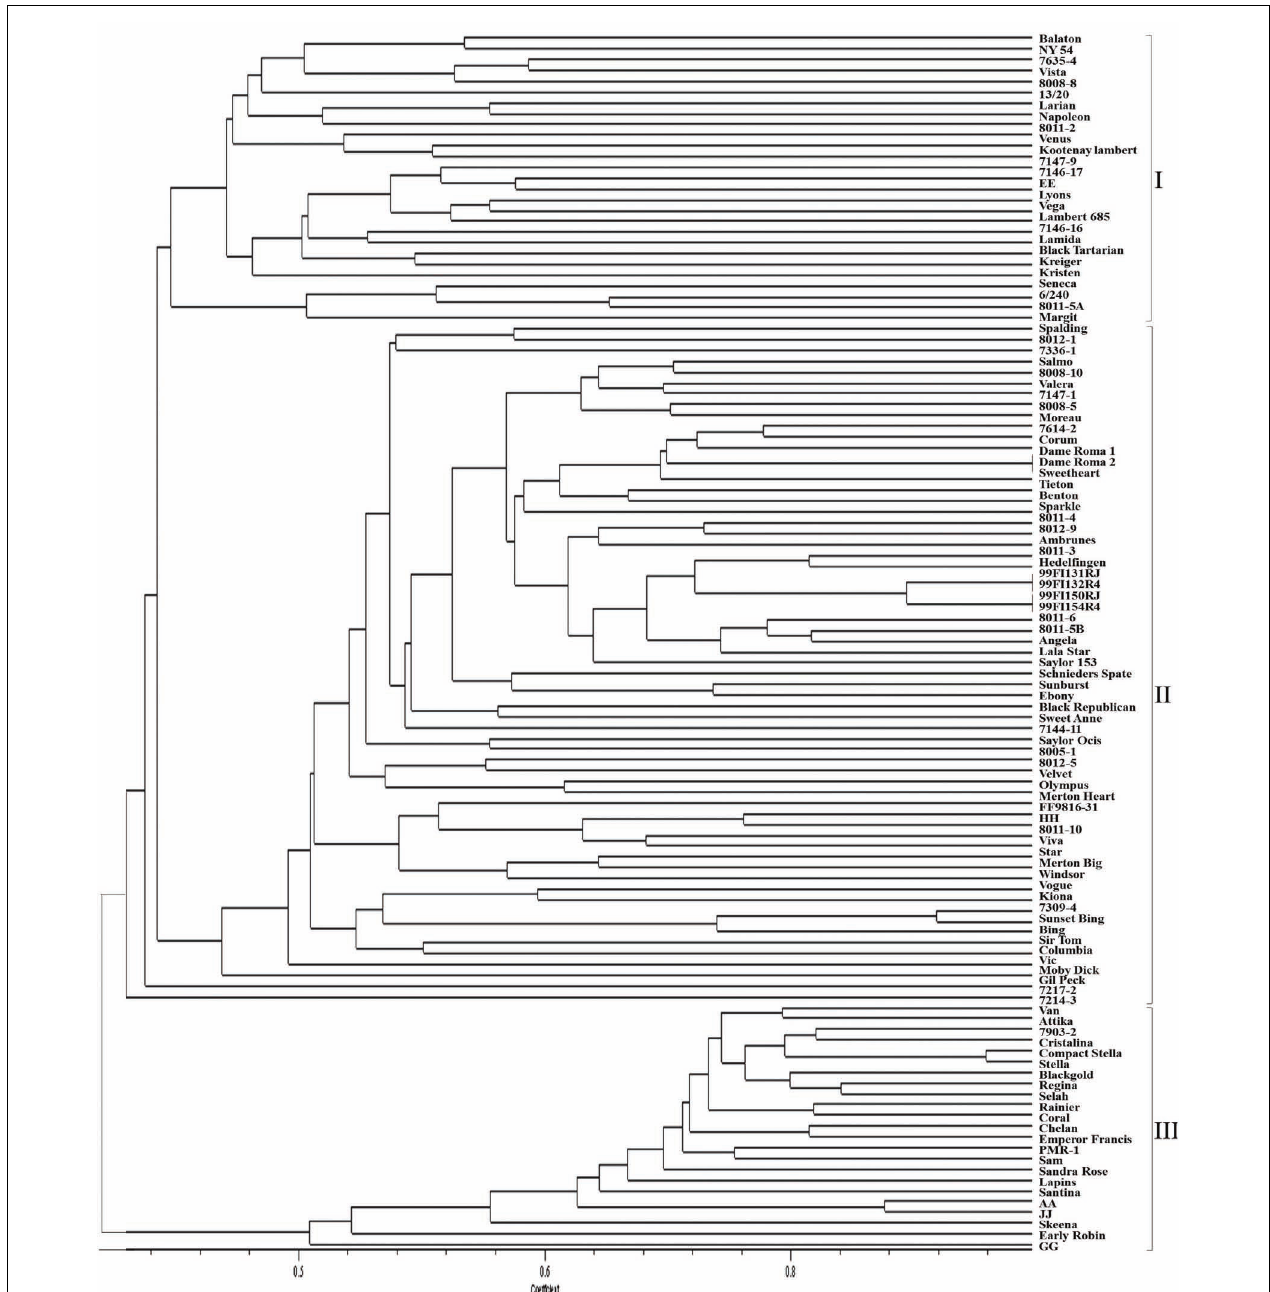
FIGURE 1 |A dendrogram based on SNP data depicting the relationships of the sweet cherry accessions.